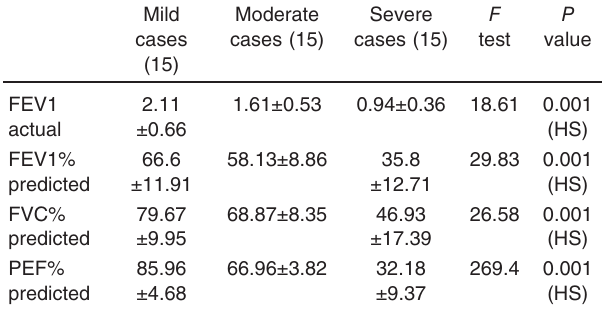
Table 2 Comparison between the studied groups according to pulmonary function tests